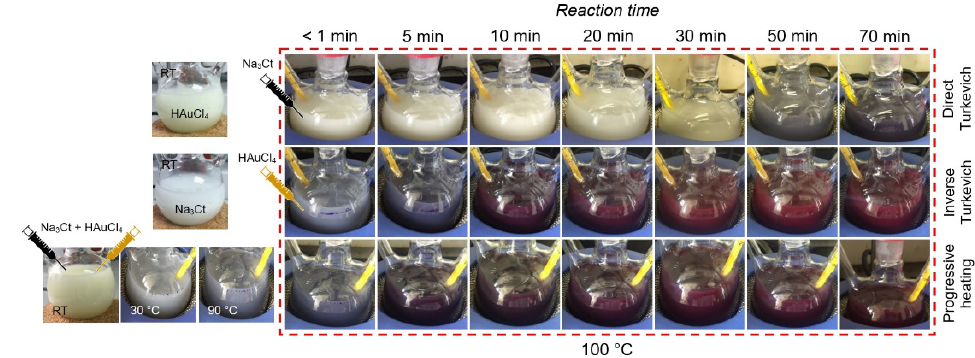
Figure 5. Evolution of the appearance of the reaction medium during the impregnation processes.